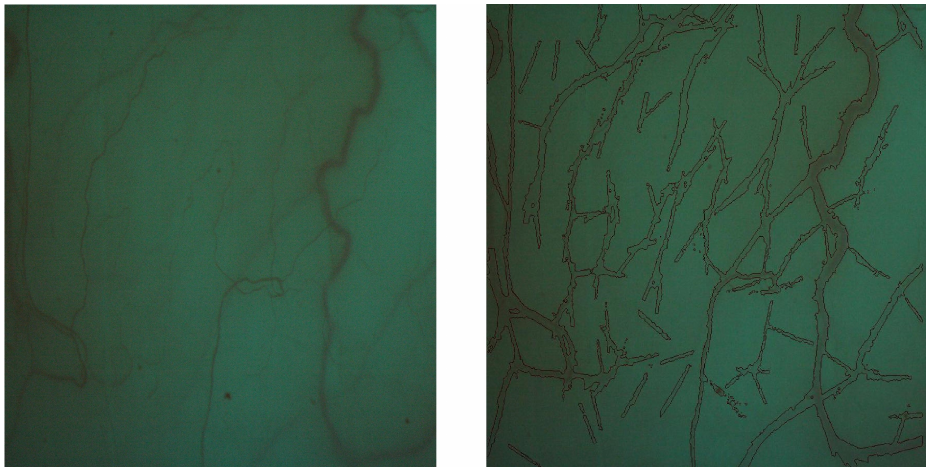
Figure 1. An example of the conjunctival images; the right image shows how the algorithm extracts the